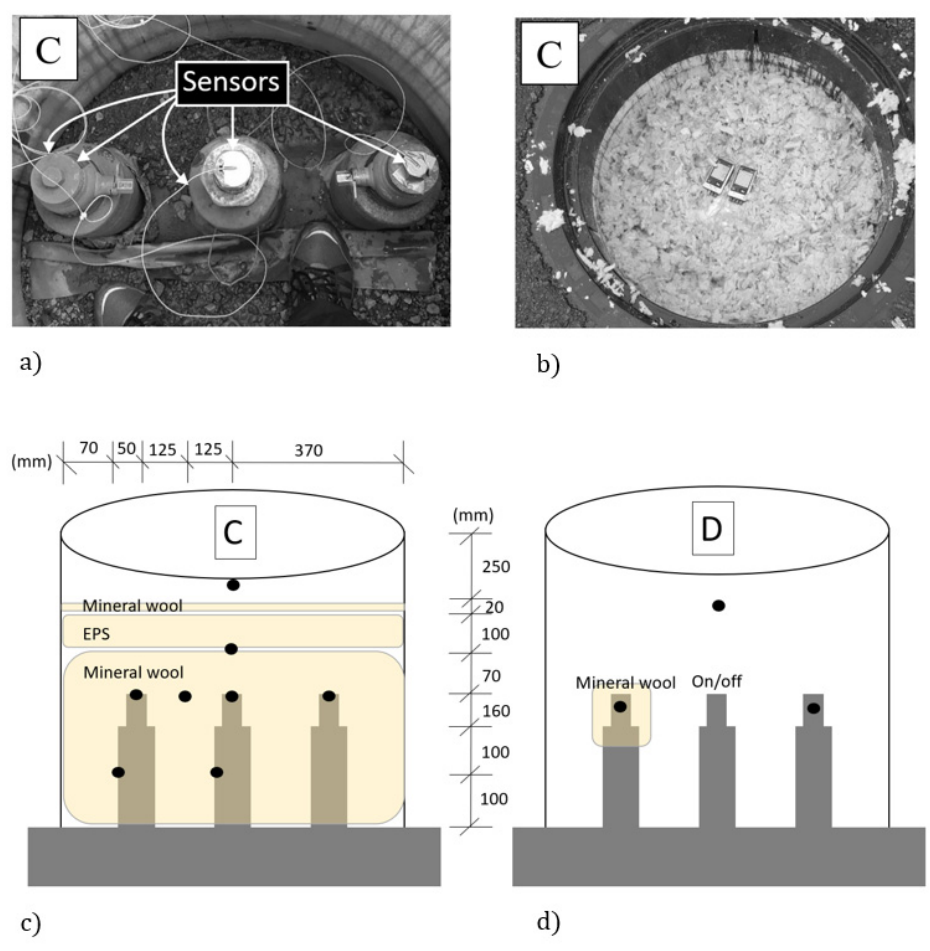
Figure 2. ( a ) Measurement set-up in manhole C showing the thermocouples installed in the manhole prior to insulation; ( b ) manhole C fully insulated after installation of thermocouples, except for the 250-mm free space (air); ( c ) thermocouple placement in manhole C (not to scale); and ( d ) thermocouple placement in manhole D.